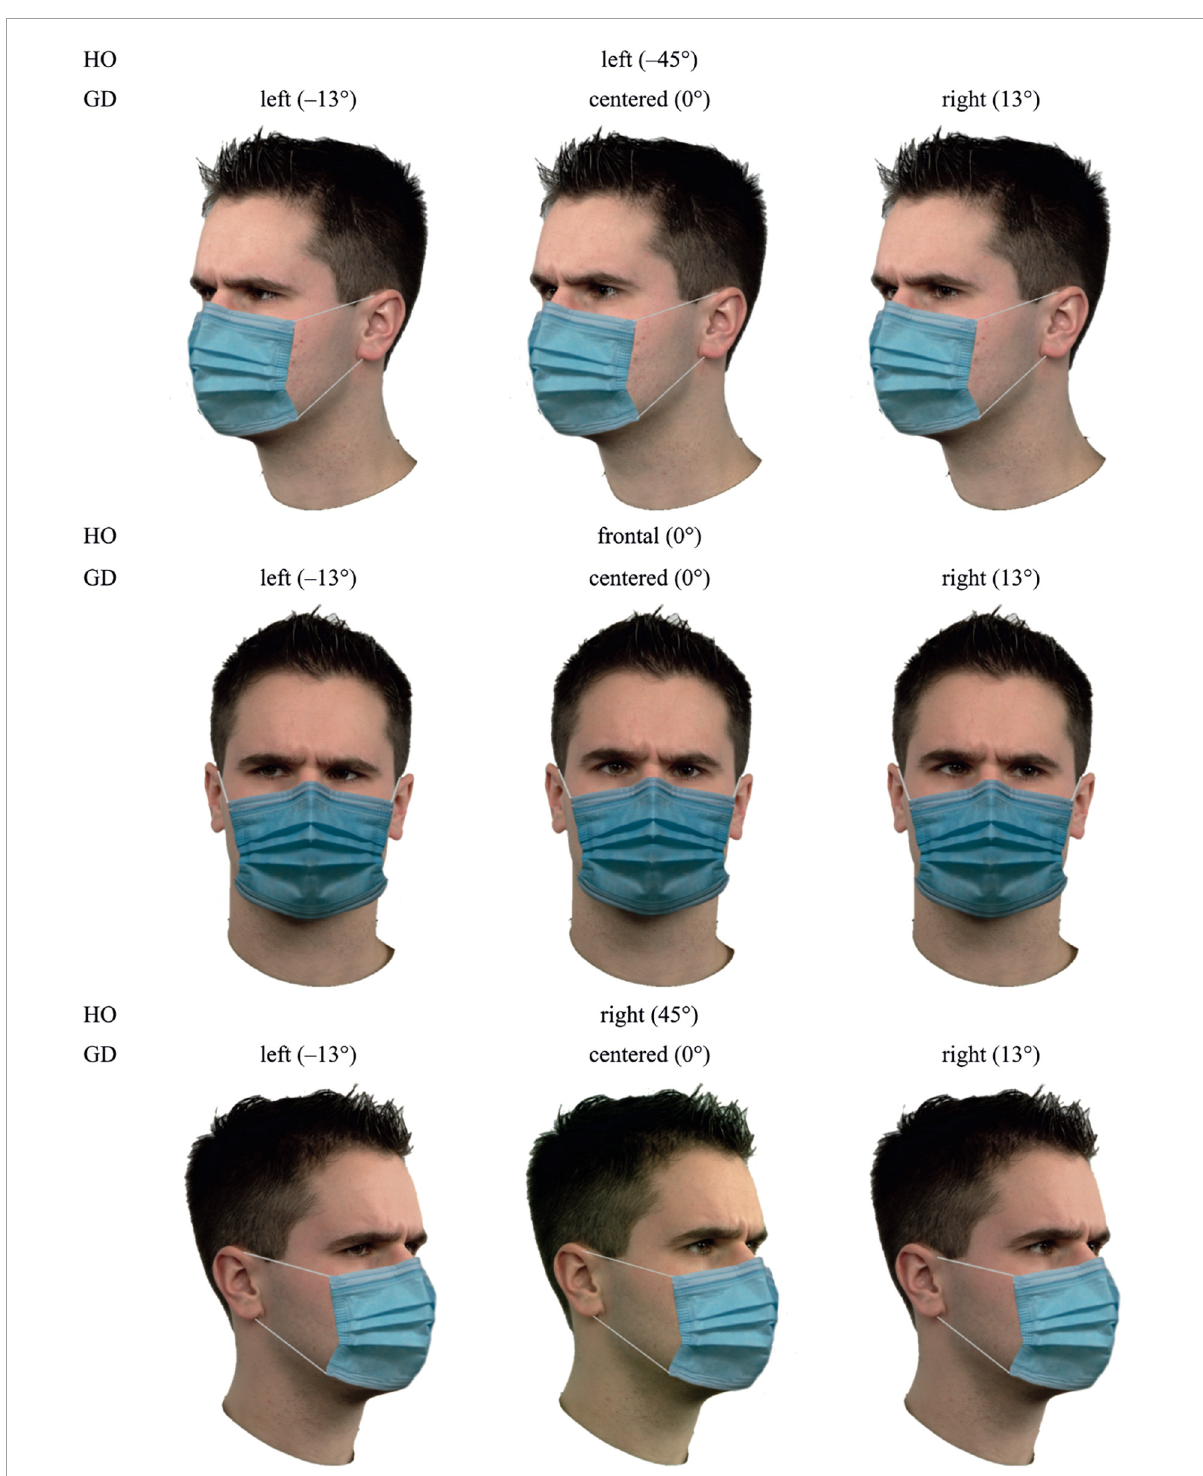
FIGURE6 Example stimuli for masked faces, showing all nine possible combinations of gaze direction and head orientation for model 20 and the facial expression anger. HO, head orientation; GD, gaze